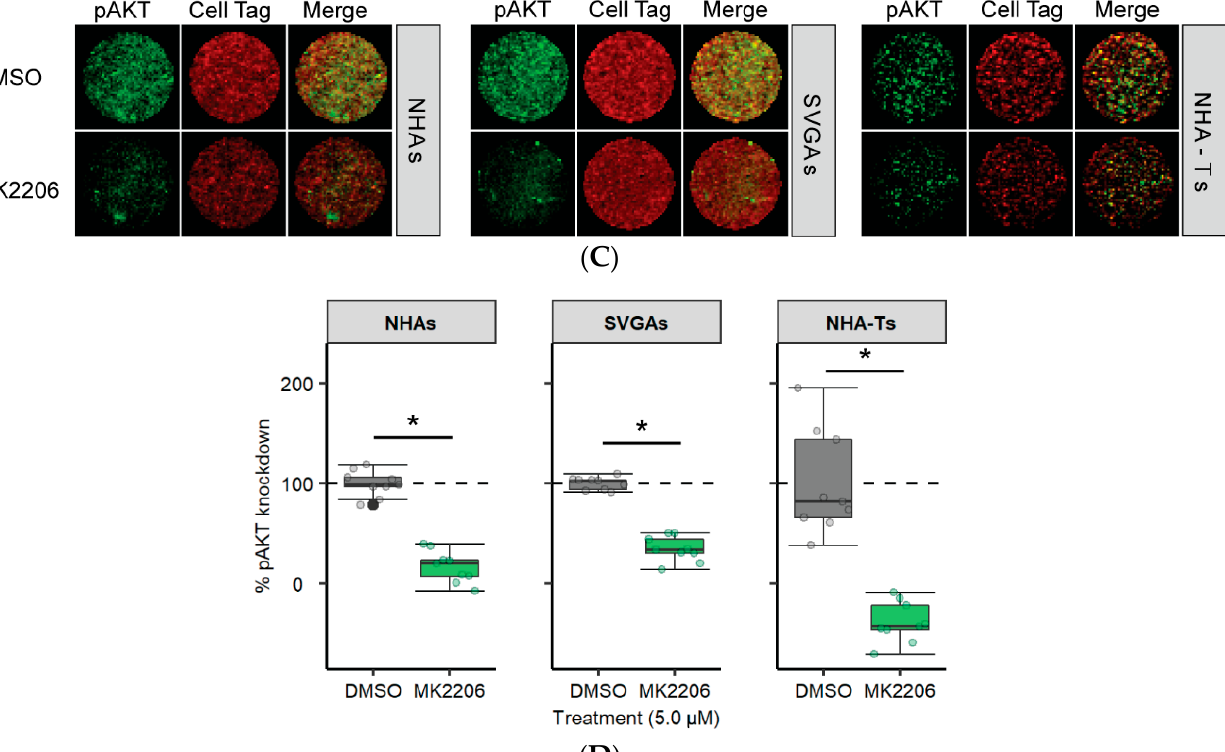
Figure 4. AKT is required for JCPyV infection in NHAs. ( A ) The log CPM was determined for the three isoforms of AKT ( AKT1 , AKT2 , and AKT3 ) in mock-infected and JCPyV-infected cells at each time point from the RNA-seq data. Colored points represent individual points for each timepoint (3 replicates). †, p < 0.10; *, p < 0.05. ( B ) NHAs, SVGAs, and NHA-Ts were pretreated with indicated concentrations of AKT inhibitor MK2206 or DMSO at an equivalent volume control for 30 min and then infected with JCPyV (MOI = 1.0 FFU/cell) at 37 ◦ C for 1 h. Cells were incubated in media containing DMSO or MK2206 for 48 h and then fixed and stained by indirect immunofluorescence. Infectivity was determined by counting the number of JCPyV T Ag-positive nuclei divided by the number of DAPI-positive nuclei for five × 20 fields of view for triplicate samples (% infection). Data is representative of three individual experiments. Error bars indicate SD. Student’s t test was used to determine statistical significance, comparing DMSO to MK2206 for each cell type. ( C ) NHAs, SVGAs, and NHA-Ts were treated with DMSO or MK2206 (5.0 µ M) at 37 ◦ C for 24 h. Cells were fixed and stained for pAKT (green) or CellTag (red). ( D ) Percentage of pAKT for each cell type was quantitated by ICW signal intensity values per [(pAKT)/Cell Tag × 100% = % response] within each ICW analysis using LI-COR software (representative image shown in C ). Box and whisker plots represent the distribution of samples (individual points) with the lower quartile, median, and upper quartile denoted as black lines. The dashed line indicates the normalized DMSO % response of pAKT. Colored points represent individual points for each treatment (3 replicates, performed in triplicate), and outliers are represented by black circles. A Wilcoxon rank sum exact test was used to compare treatments in each cell type. Data are representative of three independent experiments performed in triplicate. * p <